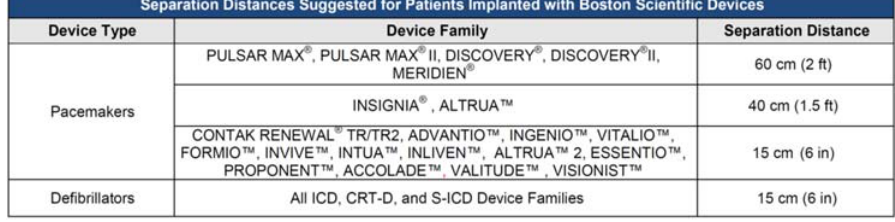
Figure 1. Suggested separation distance between RFID source (transmit antenna) and implanted device, as reported by Boston Scientific in the instruction for use their devices.